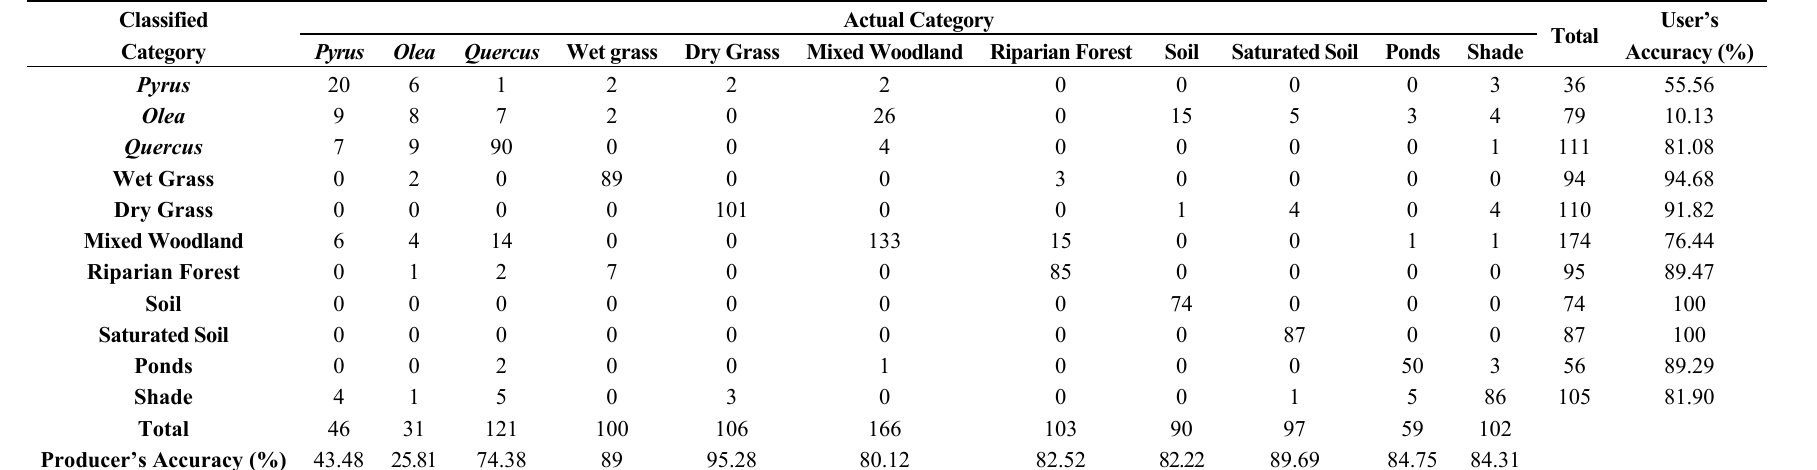
Table 7. Error matrix of the QuickBird fused image from July 2008 at 240 cm of resolution and classified by the ML method.